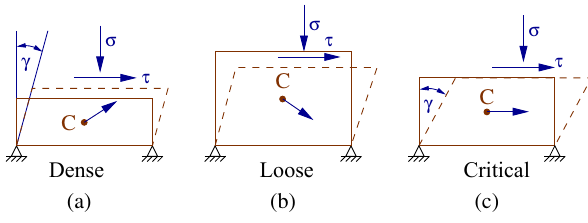
Figure 1. Simple shear test: C denotes the center of gravity with an arrow showing the direction of its displacement during